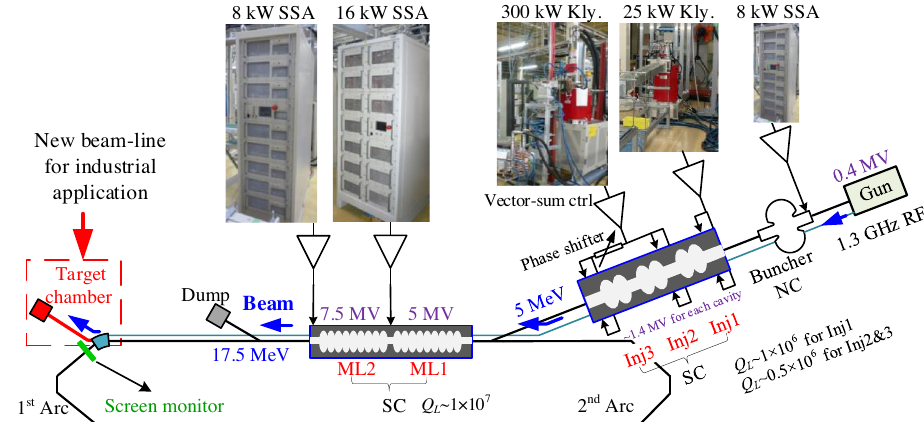
FIG. 1. Layout of cERL. Cavities and rf sources are shown in the figure. The new beamline is indicated by the red block. The marked values of the beam energy and cavity voltage indicates the latest state of the beam commissioning in CW mode. The screen monitor is indicated by the green block.